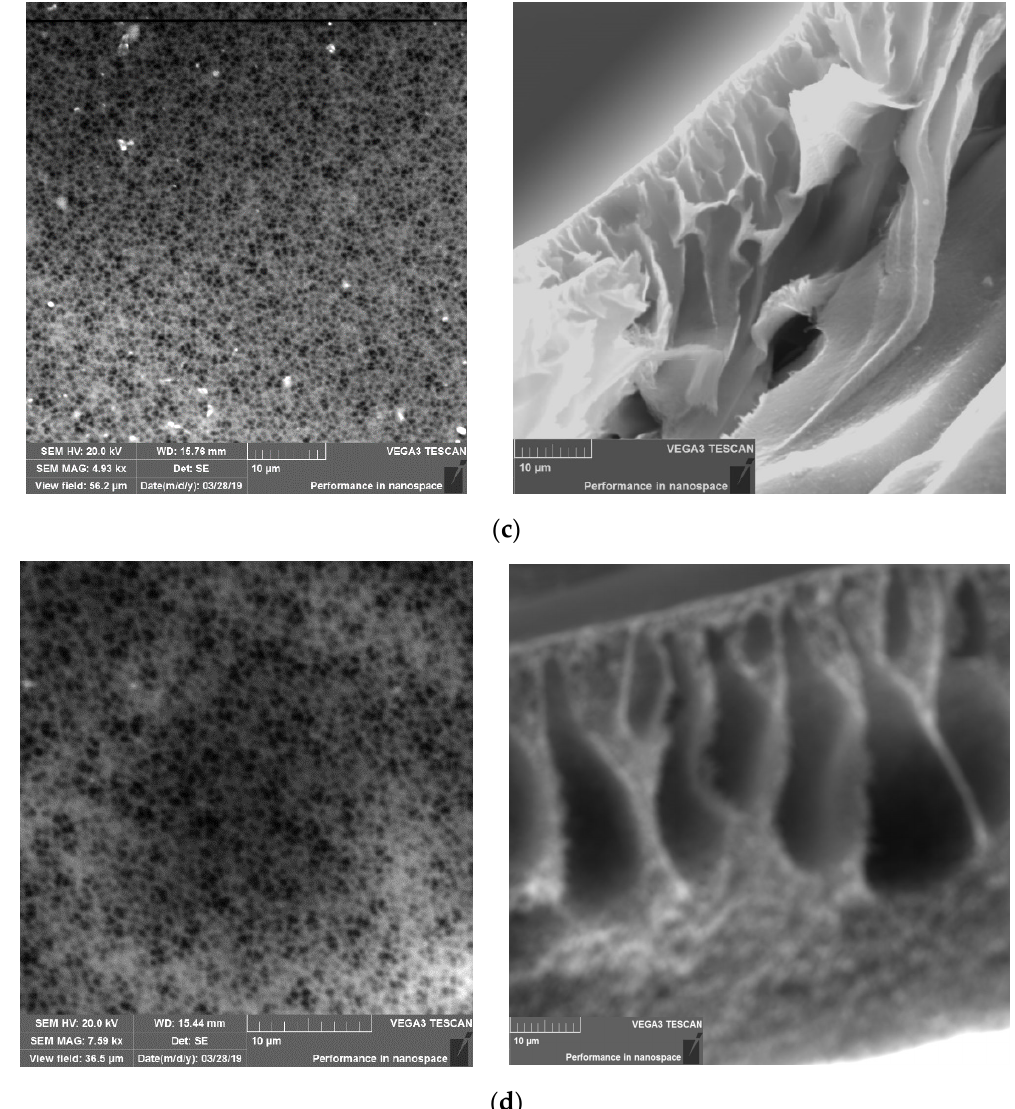
Figure 4. Characterization of the PES and CNDs/PES using scanning electron microscopy (SEM). ( a ) pure PES; ( b ) 0.01% CNDs/PES; ( c ) 0.05% CNDs/PES ( d ) 0.5% CNDs/PES.